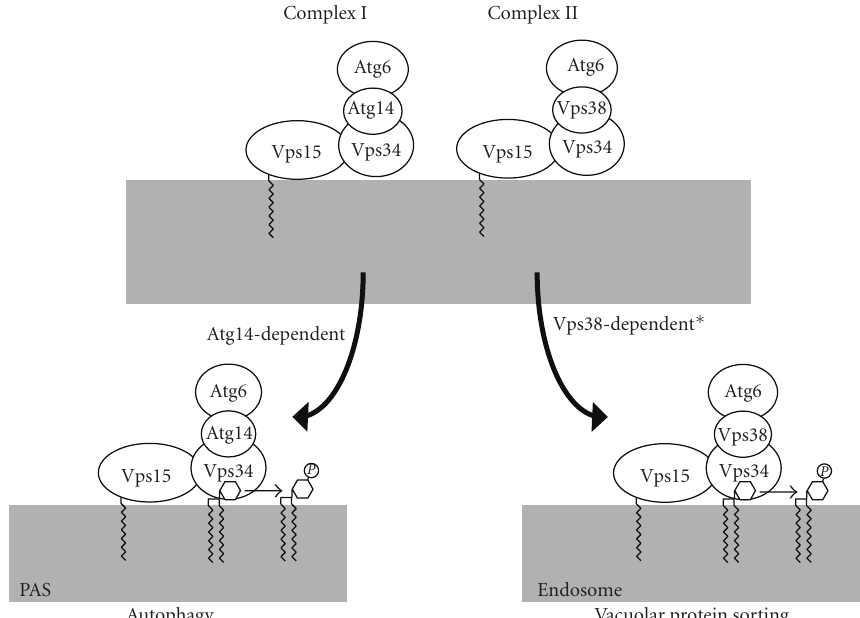
Figure 2: Mechanism by which the PtdIns 3-kinsase complexes are sorted into distinct processes. Vps34, a catalytic subunit, forms two distinct PtdIns 3-kinase complexes (complexes I and II). Complex I functions in autophagy, while complex II functions in the vacuolar protein sorting pathway. Atg14 is specifically integrated into complex I, while complex II contains Vps38 as a unique subunit. These specific subunits regulate the intracellular localization of these complexes, thereby determining their specific functions. Complex I localizes to the PAS in an Atg14-dependent manner, while complex II localizes to the endosome. ∗ The endosomal localization of the complete complex II including Vps30/Atg6 depends on Vps38. However, Vps34 and Vps15 can localize to the endosome even in the absence of